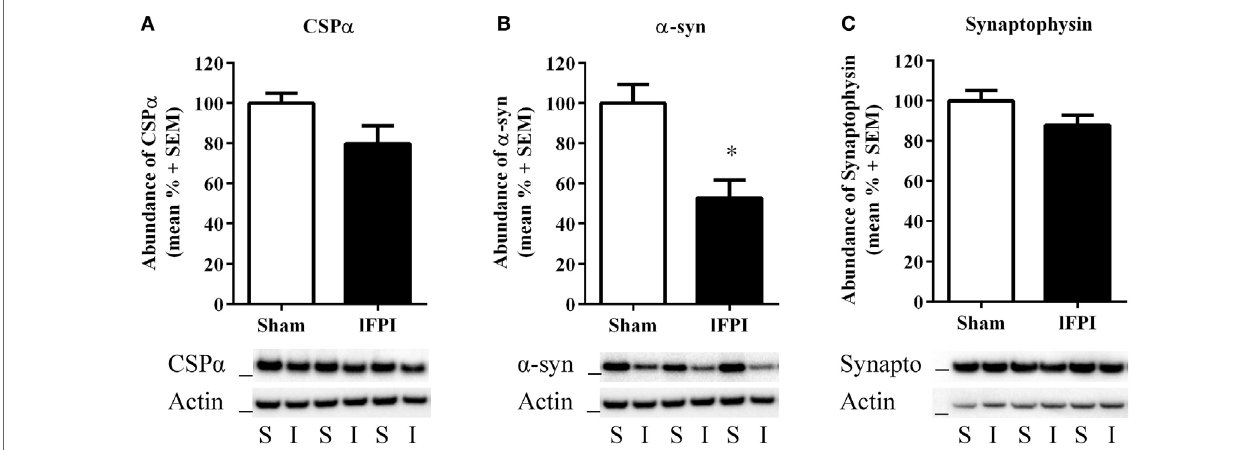
FigUre 3 | Lateral fluid percussion injury (lFPI) reduced α -syn abundance in the hippocampus. (a) Representative western blot image of CSP α in hippocampal synaptosomal lysates at 1 week post-injury ( n = 3 per group shown). Assessment of CSP α (34 kDa, marker is 28 kDa) in lFPI-injured rats (I) revealed a trend toward reduced abundance compared with sham (S) rats, but it did not reach significance. (B) Representative western blot image of α -syn (18 kDa, marker is 14 kDa) in lFPI-injured rats revealed a significant reduction compared with sham rats (* p < 0.005). (c) Representative western blot image of synaptophysin (35 kDa, marker is 28 kDa) in lFPI-injured rats revealed a small reduction in abundance compared with sham rats, but it did not reach significance. Proteins were normalized to actin (42 kDa, marker is 38 kDa) ( n = 6 sham and n = 6